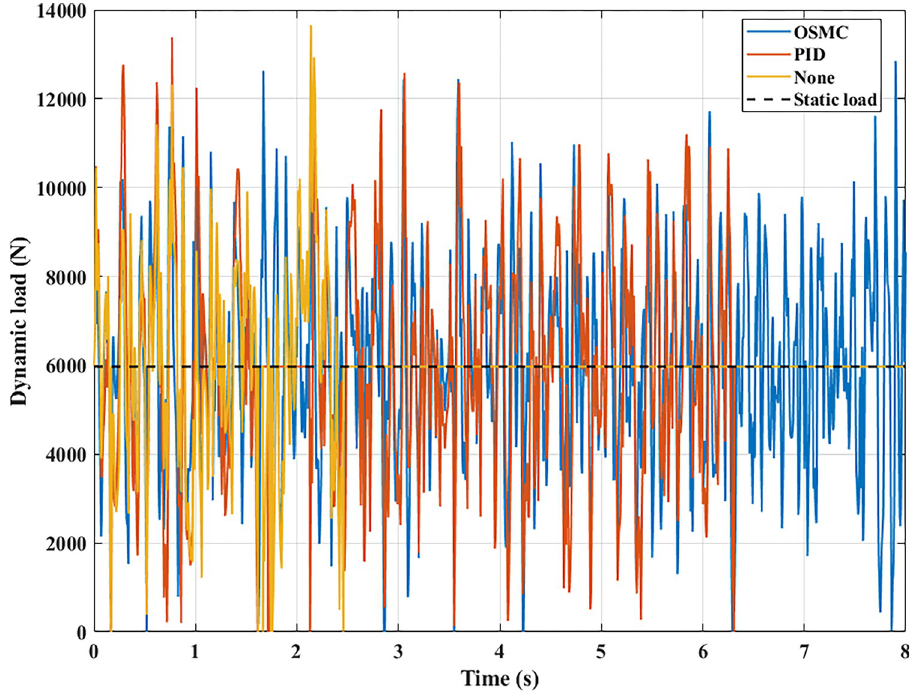
Fig 16. Dynamic load (case 4).